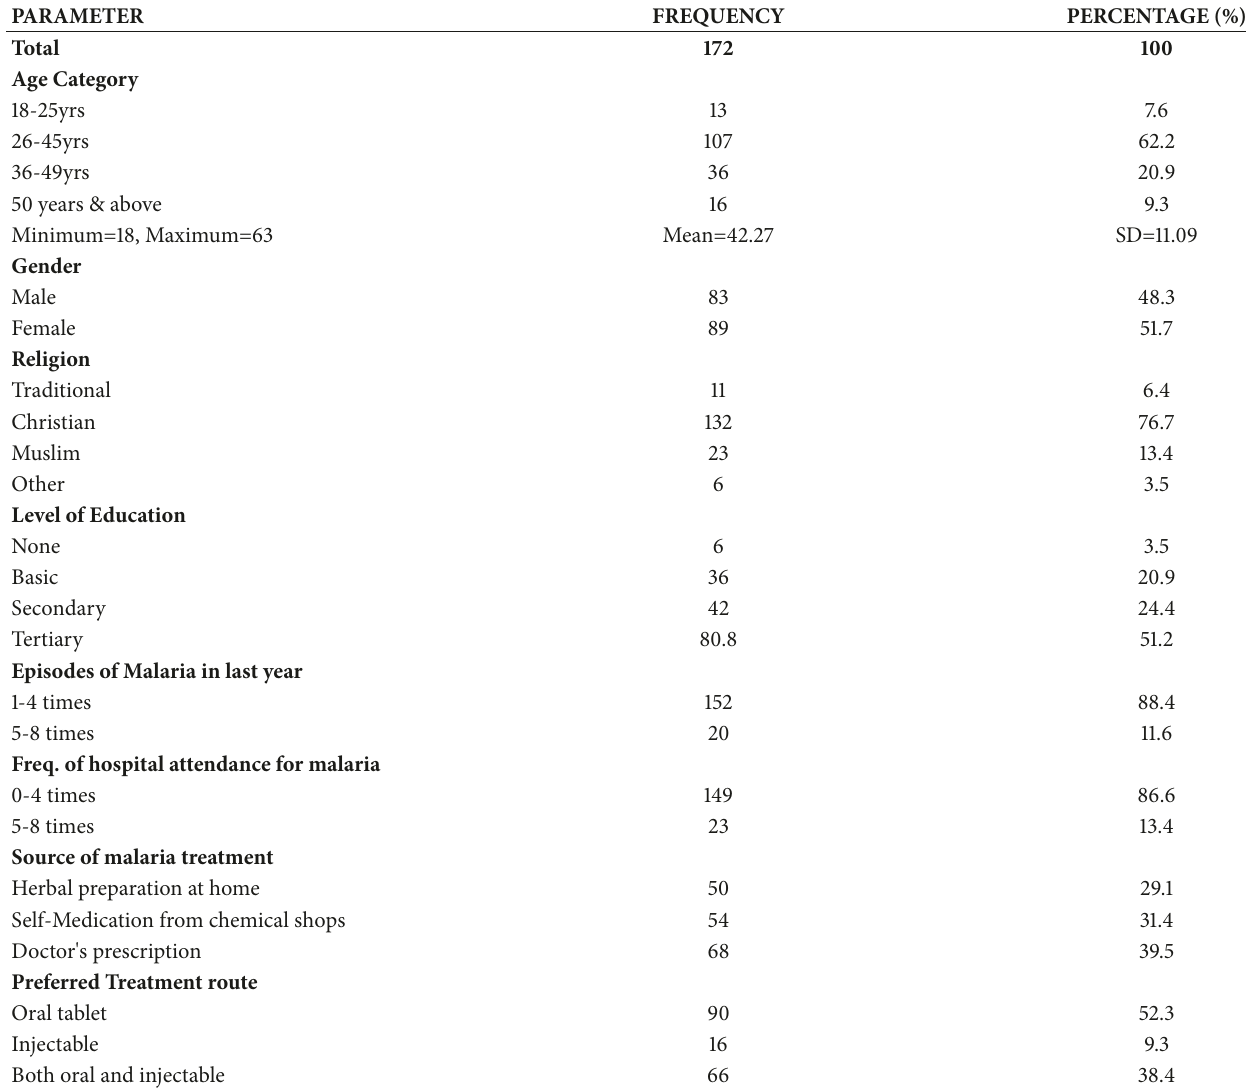
Table 1: Demographic characteristics of